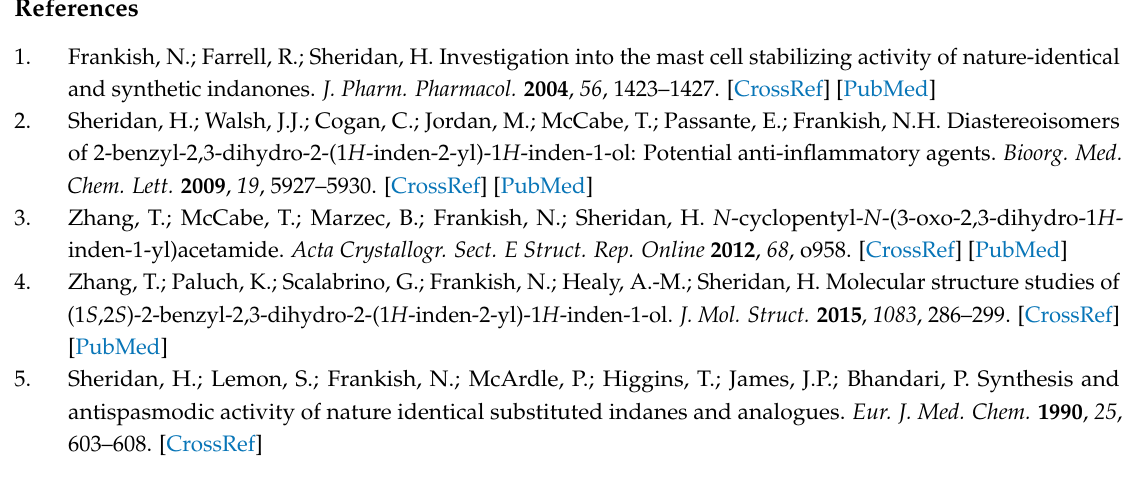
Supplementary Materials: Supplementary materials (the detailed experimental procedures for the syntheses of the chiral reference molecules and their corresponding NMR spectra and HPLC chromatograms) are available